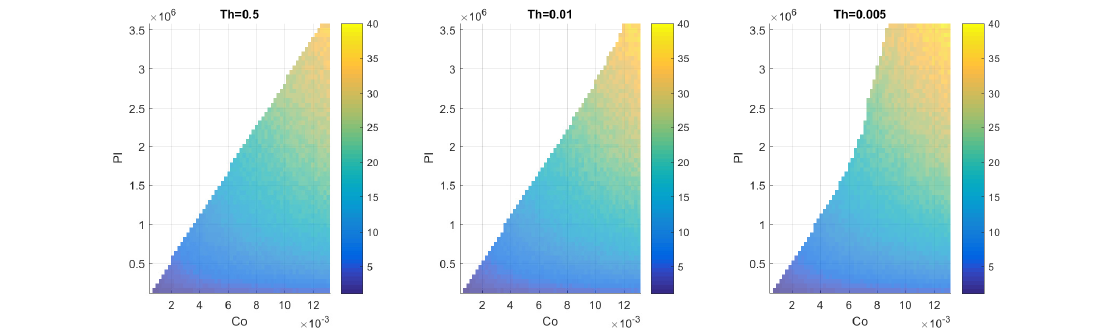
Figure 11. Frequency of oscillations as a function of Co and Pl for different values of Th for TOA =